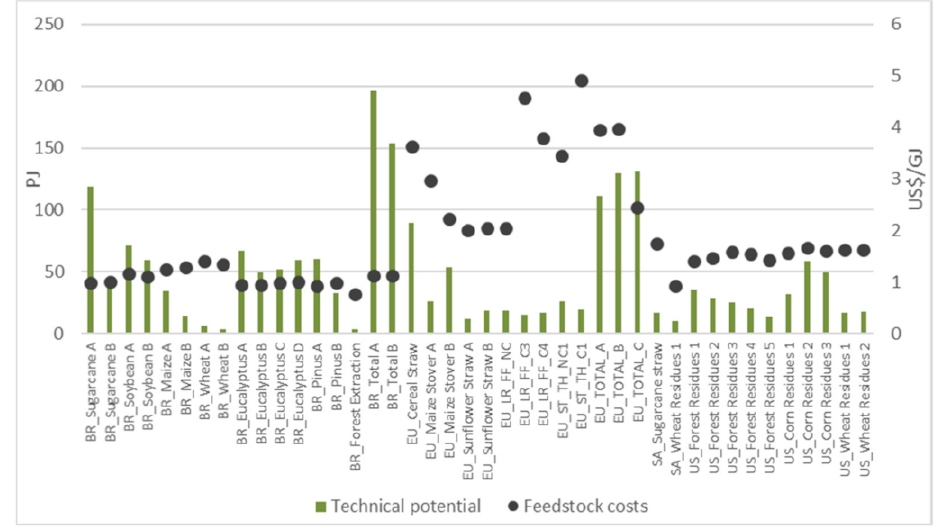
Figure 11. Biomass residues potential and average costs in hotspots.